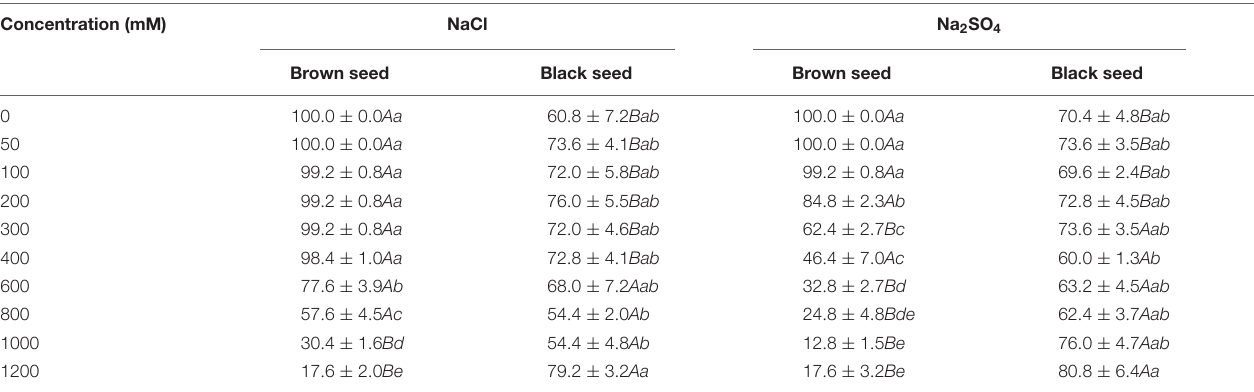
TABLE 4 | Final germination percentage of dimorphic seeds of S. salsa after treated with different concentration of NaCl or Na 2 SO 4 . Concentration